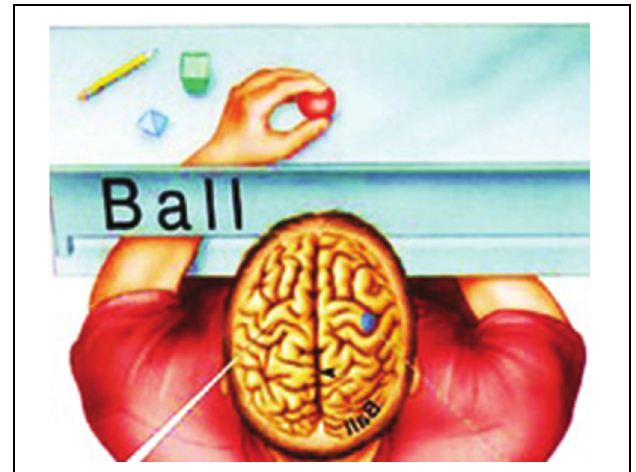
FIGURE 5 | A split- brain patient demonstrates speech auditory comprehension (‘Ball’), by picking the ball with his left hand (right motor control; Adapted from: http://thebrain . mcgill . ca/flash/capsules/ experiencebleu06 .